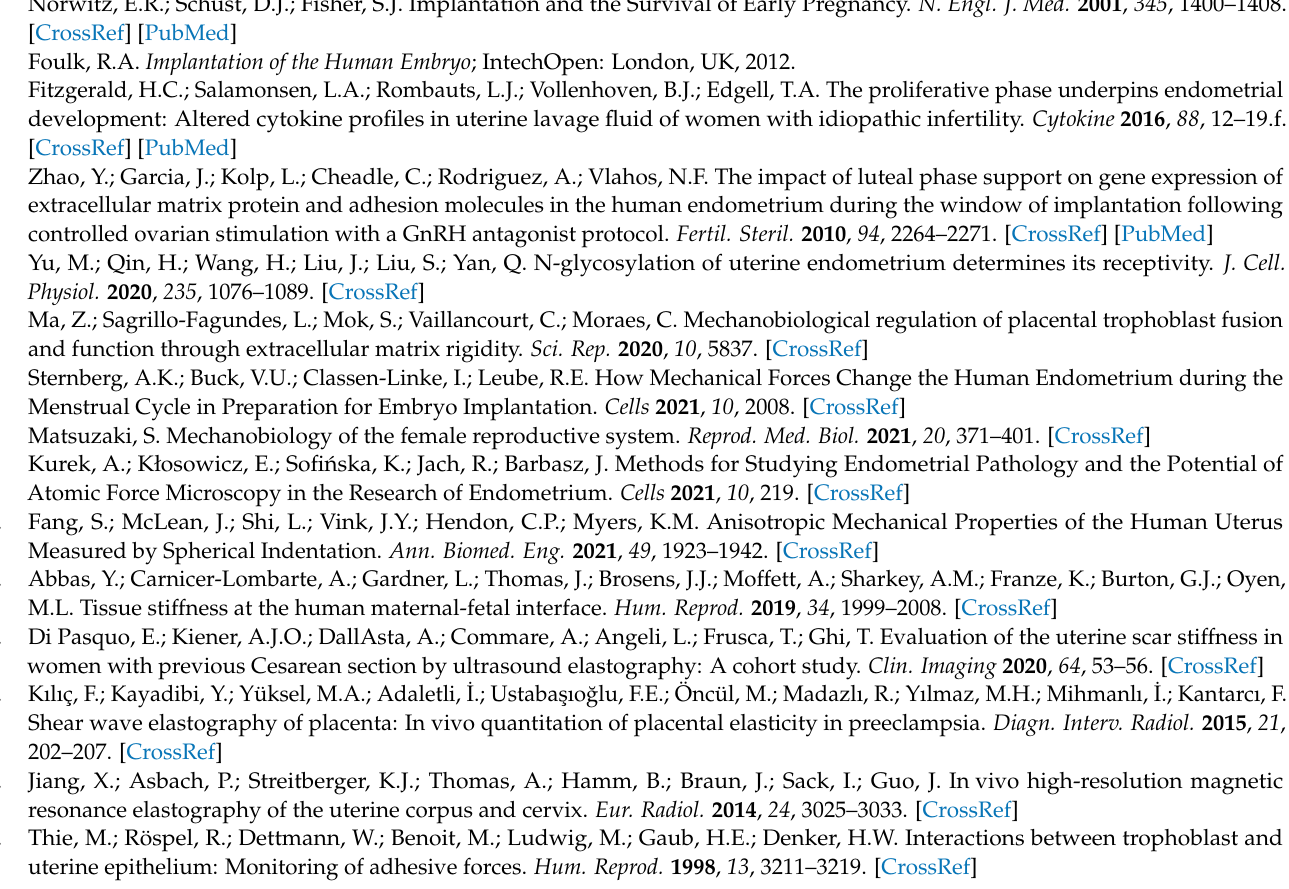
polyacrylamide hydrogel with stiffness gradient. Scale bar = 10 mm. Figure S2: SEM analysis of PA gel surface. Scale bar = 30 µ m. Figure S3: Elastic modulus measured by AFM. Data reported as mean ± standard deviation for N = 3 independent experiments. Figure S4: Left: Immunofluorescence staining of JAR cells cultured on different regions (green: integrin- β 1; blue: DAPI, scale bar: 20 µ m). Right: mean fluorescence intensity of integrin- β 1 in JAR cells cultured on different regions. n = 12, 13, 13 for Soft, Inter and Stiff, respectively. Data reported as mean ± standard